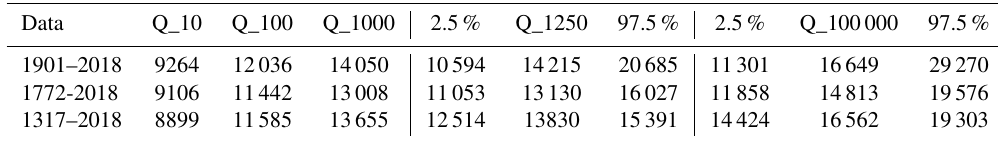
Table 2. Discharges (m 3 s − 1 ) and their 95% confidence interval corresponding to several return periods for the 1901, 1772, and 1317 data sets.